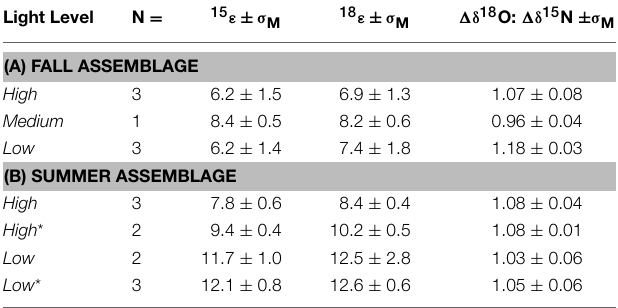
TABLE 2 | Mean N and O isotope effects of NO − 3 and 1 δ 18 O: 1 δ 15 N change and associated standard error ( σ M ) for each light treatment for the (A) late fall community incubations and (B) late summer community